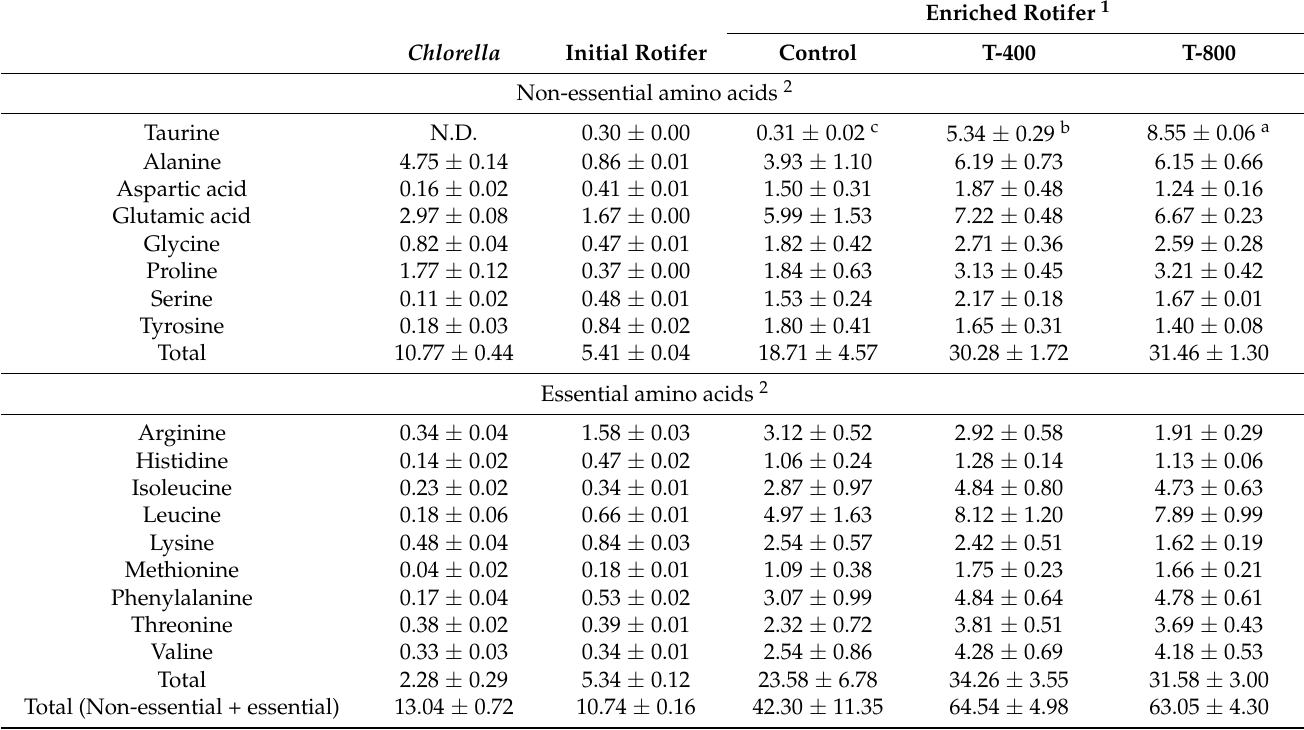
Table 1. Free amino acid content of rotifers (mg/g, dry